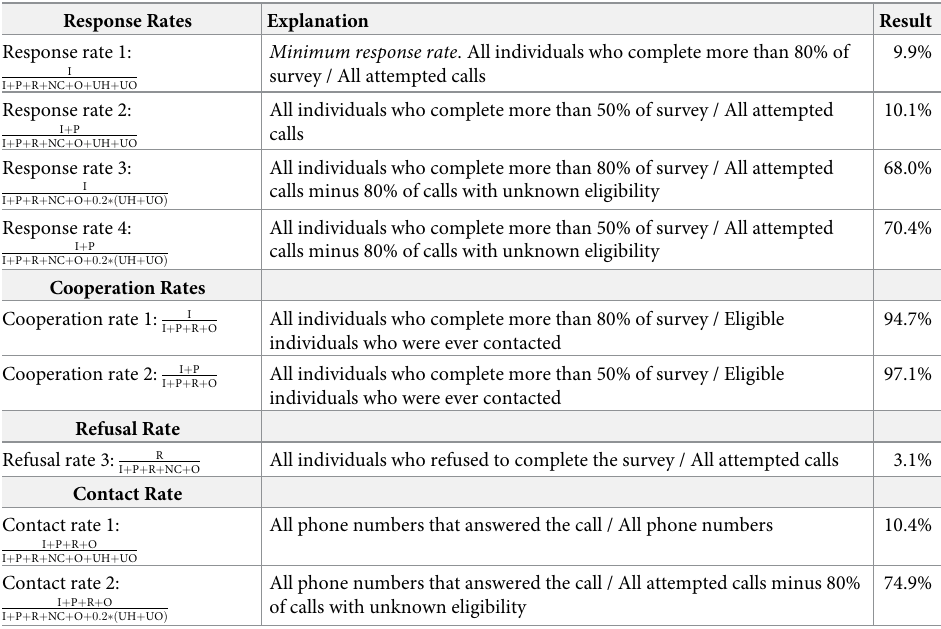
Table 3. Call outcome rates for RDD survey based on final disposition